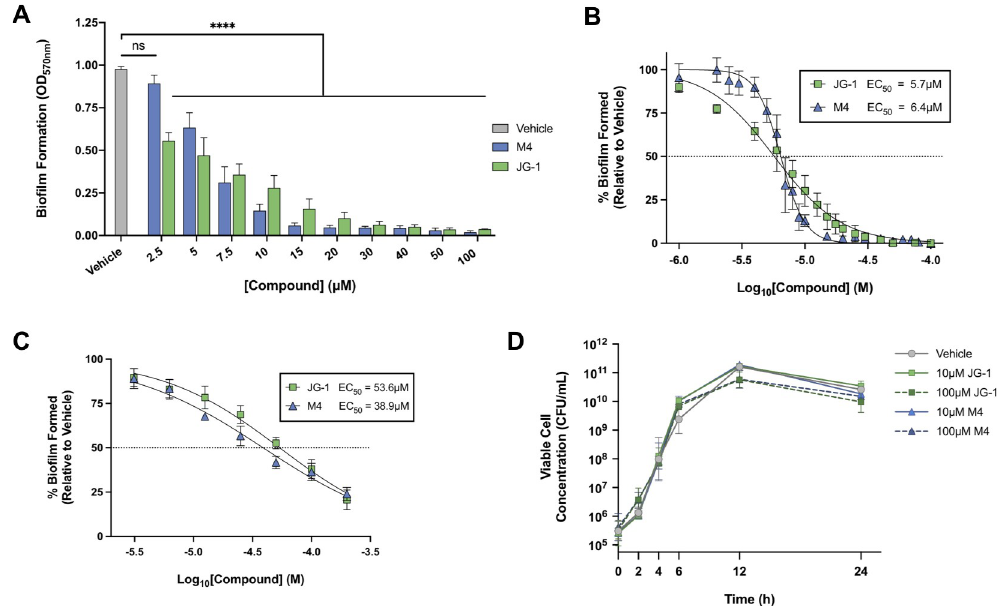
Fig 2. JG-1 and M4 inhibit Salmonella biofilm formation in a dose-dependent manner without affecting planktonic growth. A. S . Typhimurium biofilms were grown for 24 h in the presence of a vehicle control (DMSO) or various concentrations (2.5–100 μ M) of JG-1 or M4 in order to assess the dose-dependency of biofilm inhibition. Biofilm formation was measured using the crystal violet assay. Annotations above the data denote values that are significantly different from the vehicle control (gray bar), as determined by two-way ANOVA with Dunnett’s test for multiple comparisons; ns p � 0.05, ���� p < 0.0001. B. S . Typhimurium biofilms were grown as described in A , and EC 50 values for JG-1 [5.7 μ M (95% CI, 5.2– 6.2 μ M)] and M4 [6.4 μ M (95% CI, 6.3–6.6 μ M)] were calculated using GraphPad Prism 8 to plot normalized compound activity (percent biofilm formed) as a function of log 10 drug concentration and fitting a dose-response curve (log[inhibitor] vs. normalized response, variable slope). C. S . Typhi biofilms were grown in cholesterol-coated microtiter plates for a total of 96h in the presence of a vehicle control (DMSO) or various concentrations (3.1–200 μ M) of JG-1 or M4. Corresponding EC 50 values for JG-1 [53.6 μ M (95% CI, 46.4–62.3 μ M)] and M4 [38.9 μ M (95% CI, 33.6–45.2 μ M)] were calculated as described in B . D. JG-1 and M4 have no effect on the viability of planktonic S . Typhimurium. Liquid S . Typhimurium cultures were grown in the presence of JG-1, M4, or a vehicle control (DMSO) for a total of 24 h. At various timepoints, aliquots of cultures were serially diluted and plated onto LB for CFU enumeration. Two-way ANOVA with the Tukey correction for multiple comparisons revealed no significant differences at any timepoint. All data are presented as the mean +/- SD.